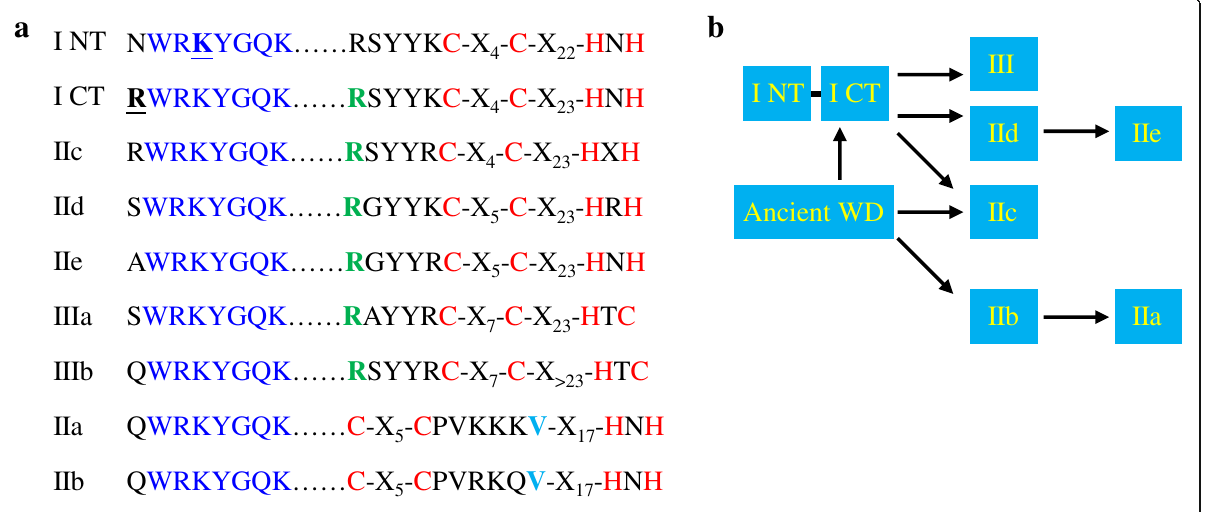
Fig. 1 Scheme of WRKY domain evolution. a Representative WRKY domain (WD) of each (sub)group. The consensus amino acid sequences of WDs from rice. The conserved zinc finger in red; the green R in bold for the conserved R-intron (phase 2), but the R-intron in Chlamydomonas reinhardtii at the position of underlined bold R (I CT line) instead; the light blue V in bold for the conserved V-intron (phase 0) of subgroups IIa and IIb. One of the introns in I NT of C. reinhardtii is at the position of underlined K (phase 2) in bold , however intronless for rice and Arabidopsis I NT WDs. b Hypothetical WD evolution. A hypothetical ancient WD existed as the ancestors of all WRKY genes. The ancient WD diversified to I CT/ IIc and IIb structures. The IIa and IIe WDs were deduced from IIb and IIe, respectively. The I NT WD is possibly gained by domain duplication and then subfunctionization. I NT and I CT for N- and C-terminal group I WD, respectively; arrows for the direction of